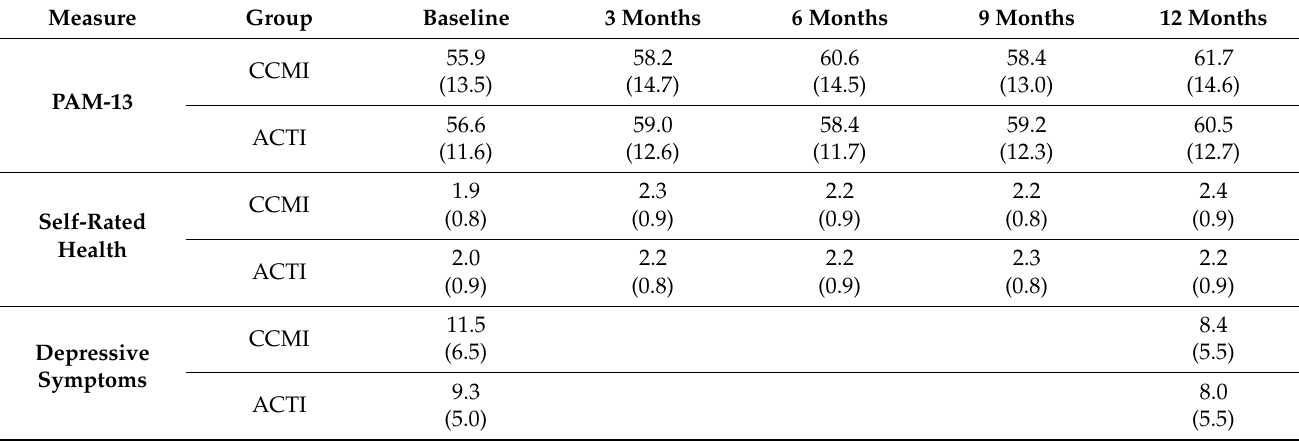
Table 2. Means and standard deviations (in parentheses) of key, clinical trial measures across time and treatment group.